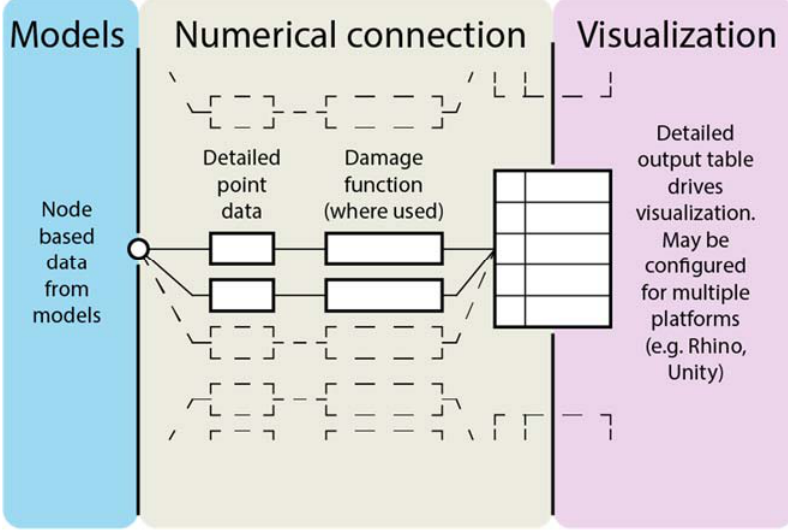
Figure 8. Basic workflow from model(s) to visualization. Output tables may be directly linked to information dashboards or designed to be ingested by visualization platforms such as Unity. Image: Authors.